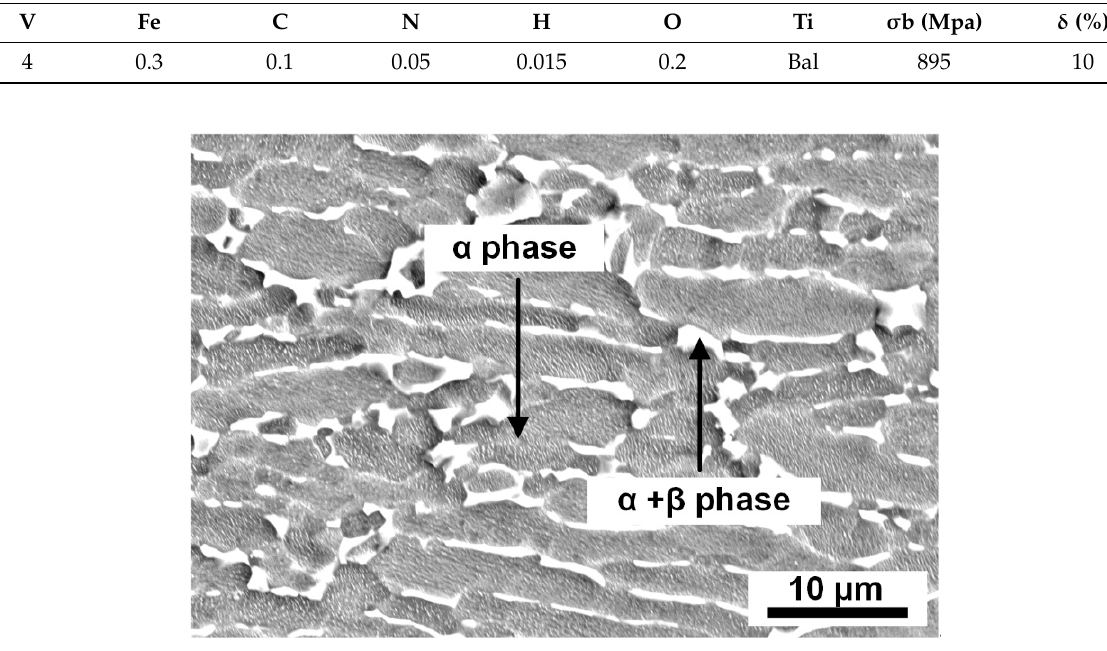
Figure 1. Microstructure of TC4 titanium alloy base metal. Table 1. Main chemical constituents and mechanical properties of Ti-6Al-4V titanium alloy. Chemical Constituents (%).